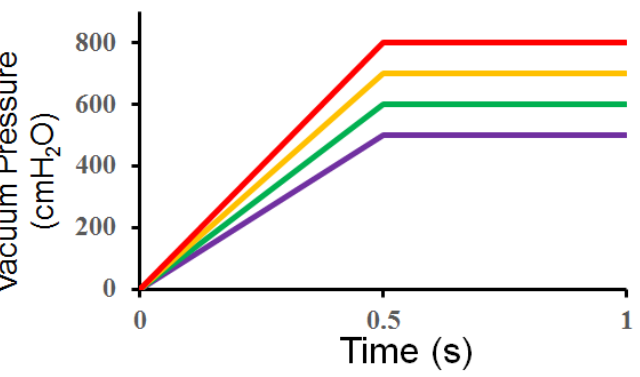
Figure 2. Magnitude of load conditions used in this study. Vacuum pressure applied to the crown area of fetal head.